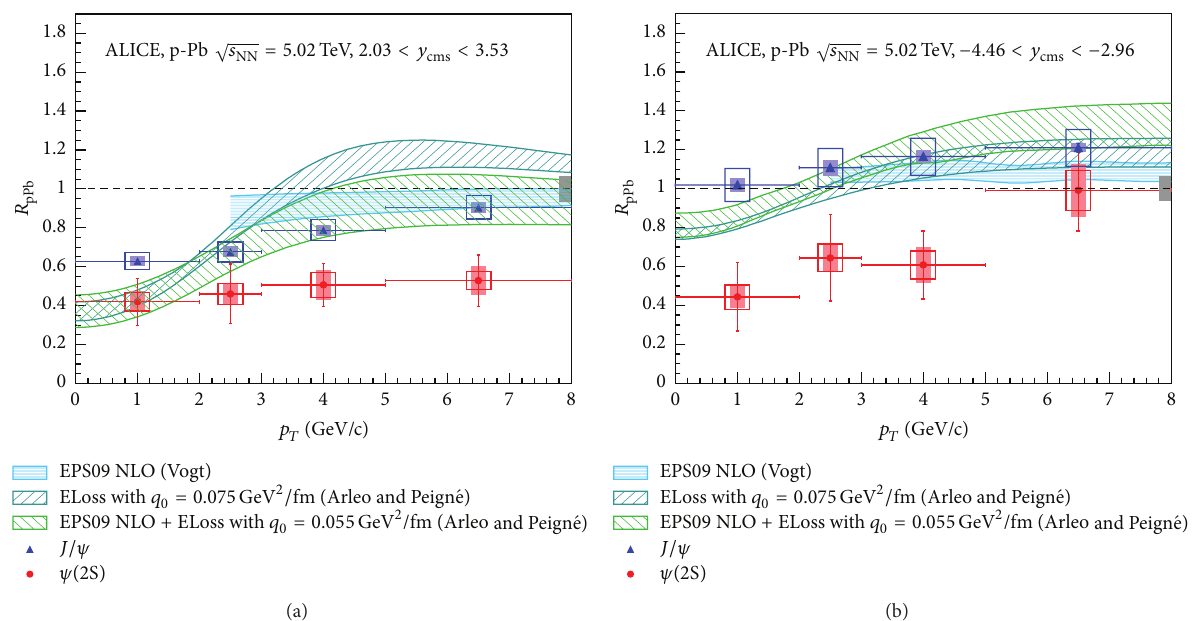
Figure 5: Comparison of ALICE 𝑅 pPb results for 𝐽/𝜓 and 𝜓 (2S) at forward (a) and backward (b) rapidity with theoretical predictions.